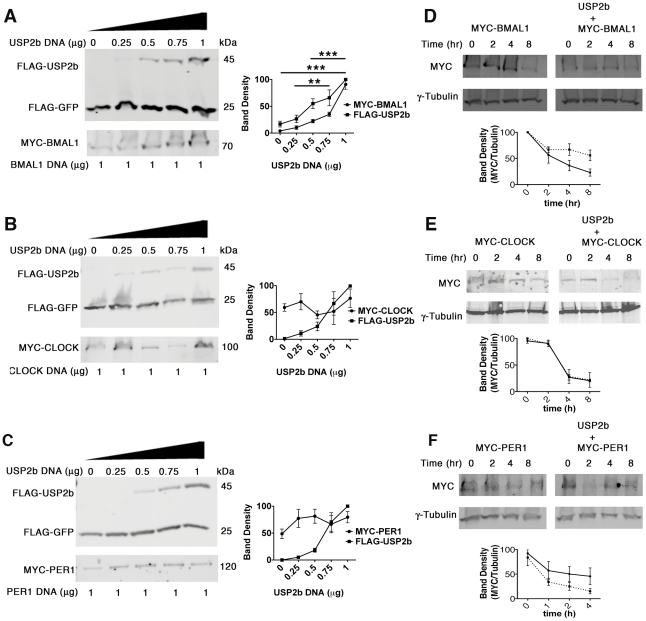
BMAL1, CLOCK and PER1 abundance in the presence of USP2b.
A-C. Increasing FLAG-USP2b plasmid (0–1 µg) was co-transfected in HEK293 cells with constant (1 µg) bicistronic plasmid encoding FLAG-GFP along with MYC-BMAL1 (A), MYC-CLOCK (B), or MYC-PER1 (C). FLAG-GFP is constant in each lane but as the concentration of FLAG-USP2b construct increased more MYC-BMAL1 (A) was also detected. Plots to the right of each western blot are mean +SEM (N = 3) band density of FLAG-USP2b (squares) or MYC-BMAL1 (circles) (A), CLOCK (B), or PER1 (C). Band densities were normalized to FLAG-GFP as a function of amount of FLAG-USP2b plasmid. One way-ANOVA was used to determine if target protein changed as a function of increasing USP2b. Bars connect points on the plot for BMAL1 that are significantly different from each other and asterisks signify p values (***p<0.0001 and **p<0.001). D–F. A bicistronic vector encoding either FLAG-GFP along with MYC-BMAL1 (D, left), CLOCK (E, left), or PER1 (F, left), or FLAG-USP2b along with the same target protein (D–F, right) was transfected into HEK293 cells. After 24 hours the cells were incubated with cycloheximide (20 µg/ml) for the indicated periods of time (X-axis). Western blotting of total protein lysates with anti-MYC was used to measure the levels of MYC-BMAL1, -CLOCK, and -PER1. Plots below Western blots are mean +SEM for three independent experiments in which target protein band density was normalized to that of γ-tubulin as a function of time in cycloheximide. Solid lines represent co-expression of target protein with FLAG-GFP and dashed lines are with FLAG-USP2b. We used regression analysis to estimate BMAL1 half-life in the absence of USP2b and found that value (3.9 hrs) significantly (p<0.05) increased to greater than 8 hrs in the presence of USP2b. Significant changes were not seen for CLOCK or Per1.